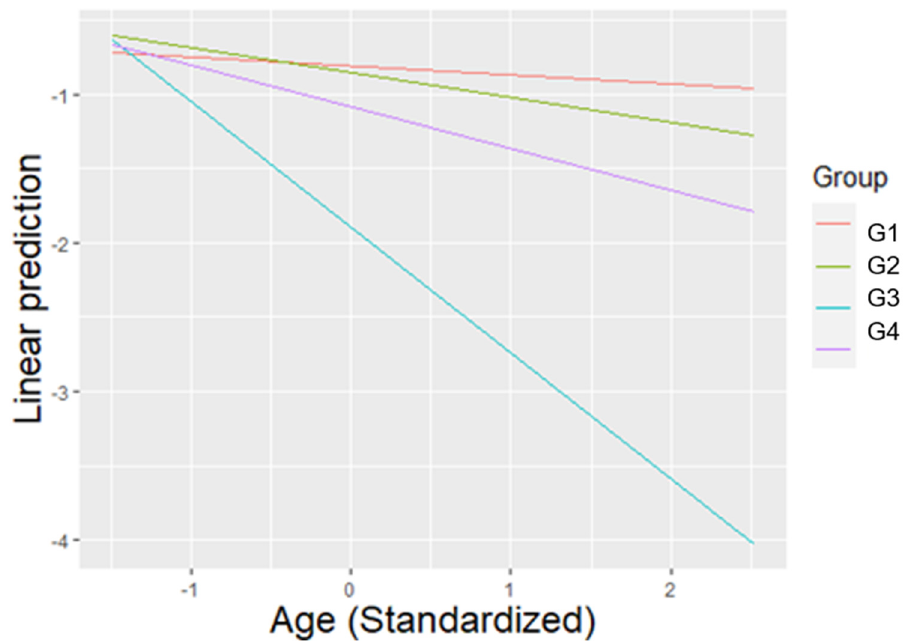
Figure 3. The linear prediction for SCI according to the average value of age (previously standard- ized), for each group. For the average value of age, Group 3 presented significantly lower SCI than all other